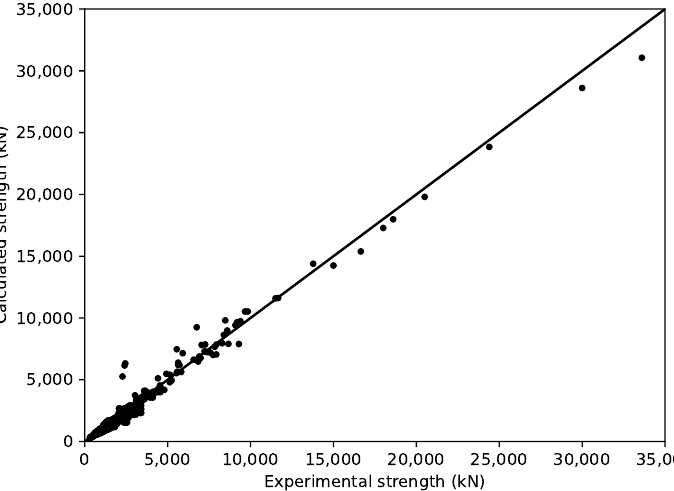
Figure 13. General scope of the design parameters of the axially loaded CCFST columns.